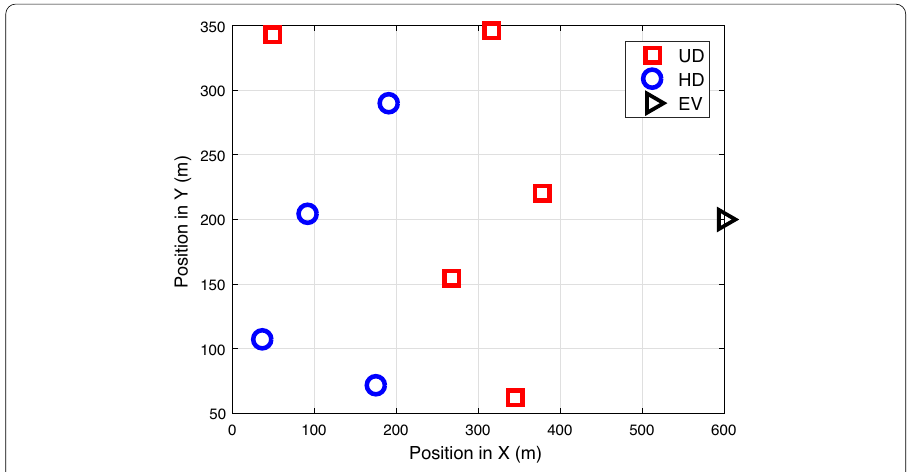
Fig. 4 The illustration of the location of UDs, HDs, and EV (Take K = 5, W = 4 for example)